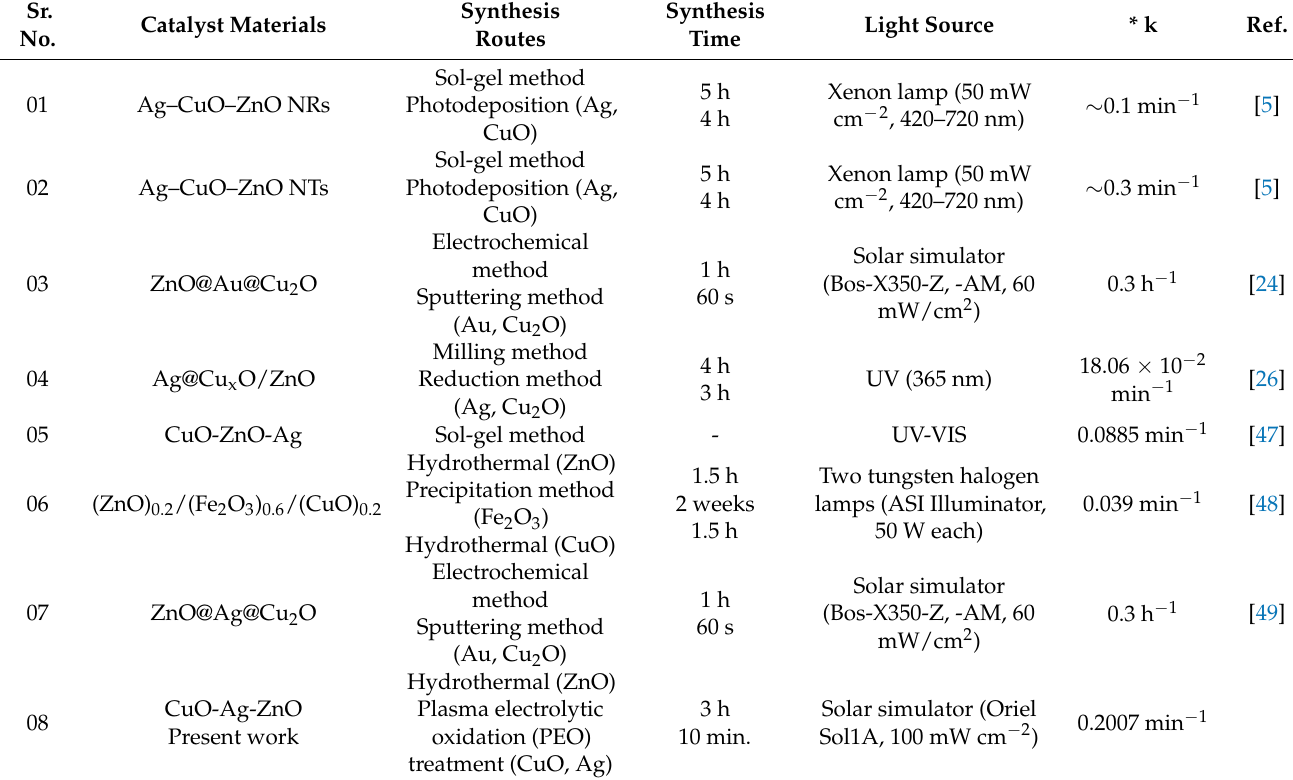
Table 1. A comparative table of photodegradation of MO dye